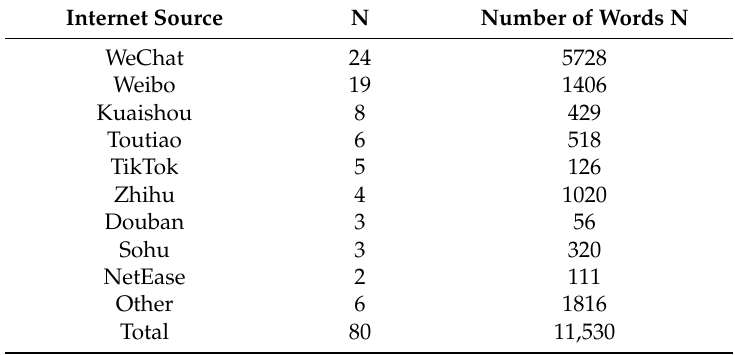
Table 8. Number of items for each Internet source used; 2020 Banner survey; N = 11,530. Internet Source